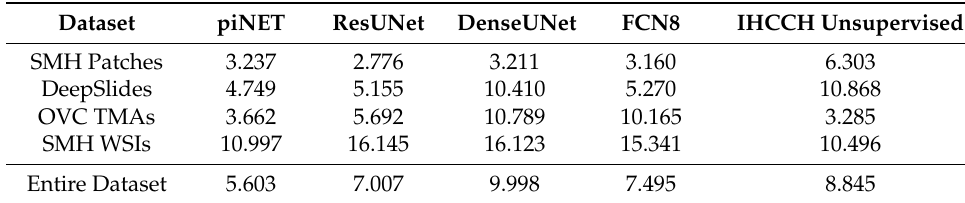
Figure 18. ( a ) PI difference of piNET over four datasets compared to three deep learning methods (ResUNet, DenseUNet, FCN8) and an unsupervised method (IHCCH). ( b ) Correlation between automated and manual PI overall datasets and for each method. Table 8. Comparison of average PI difference across four